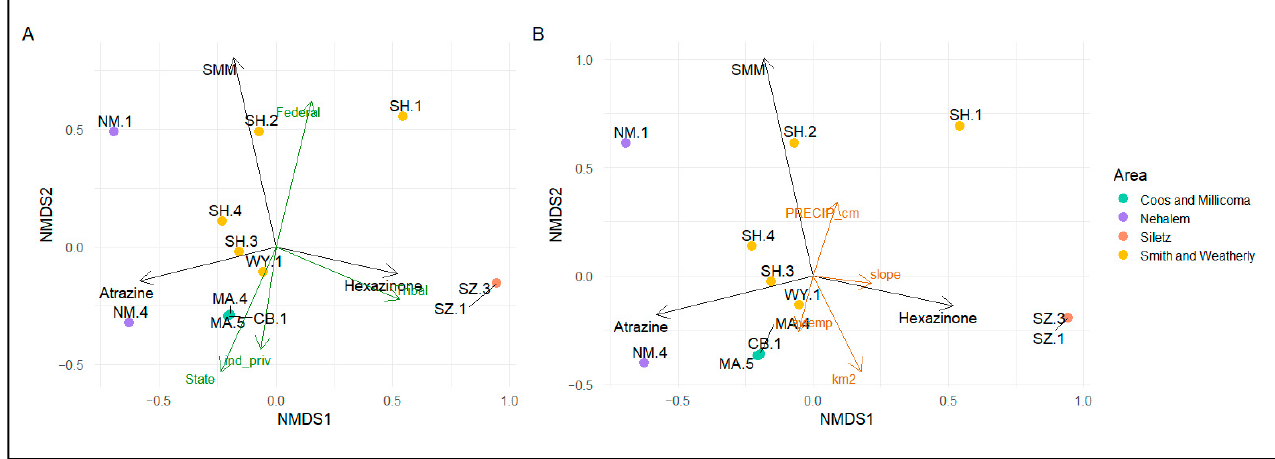
Figure 5. Non-metric multidimensional scaling (NMDS) biplots (stress = 0.017) indicate types of herbicide detections (black vector arrows) across ( A ) site types: ownership/management variables (green vector arrows) and ( B ) associated watershed characteristics: physical watershed variables (orange vector arrows). Similar vector directions of compounds and watershed characteristics indicate associations between the two. Watershed areas are indicated by point color. Detection concentrations were log transformed and the distance matrix was calculated using the Bray–Curtis metric. Abbreviations: ind_priv = industrial and private land ownership, avertemp = average temperature, km 2 = square kilometers of watershed, PRECIP_cm = annual precipitation in centimeters, SMM = sulfometuron methyl.